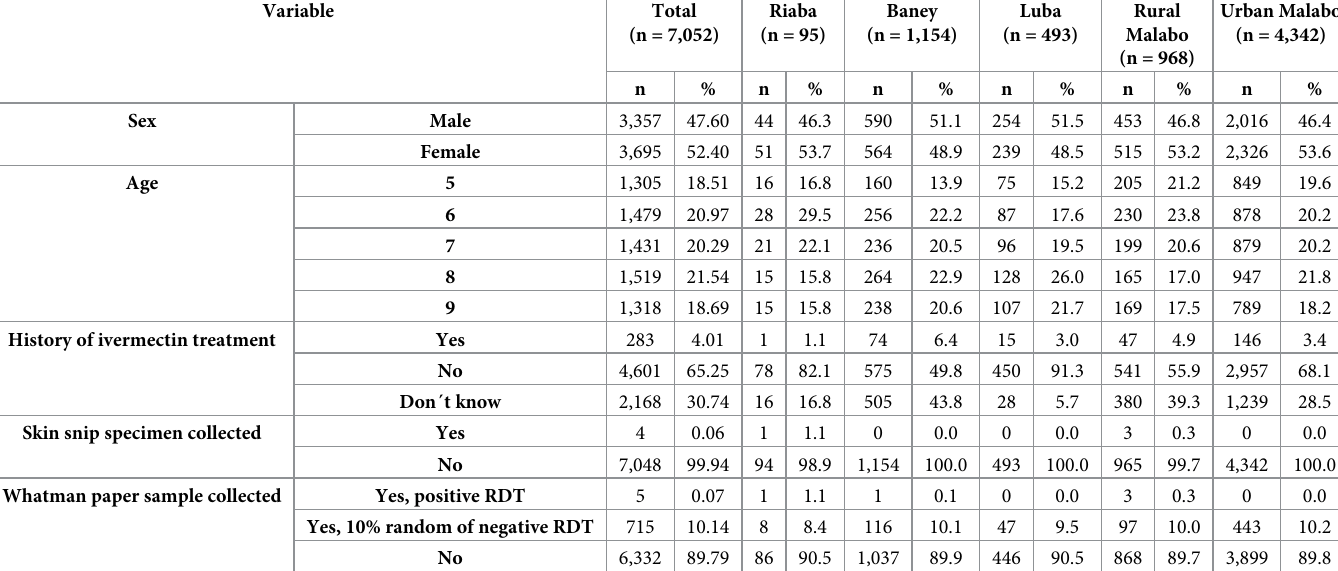
Table 1. Characteristics of the sample by district, Bioko Island, September 2016 to January